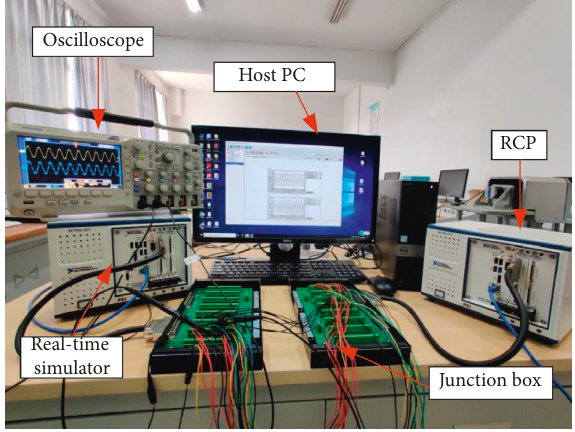
Figure 12: HIL simulation platform.